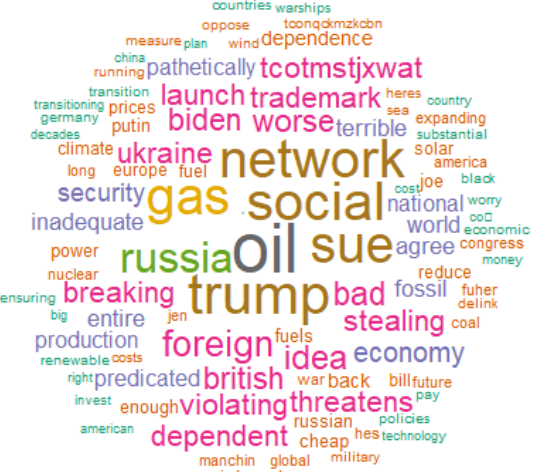
Figure 5. Wordcloud period 2.